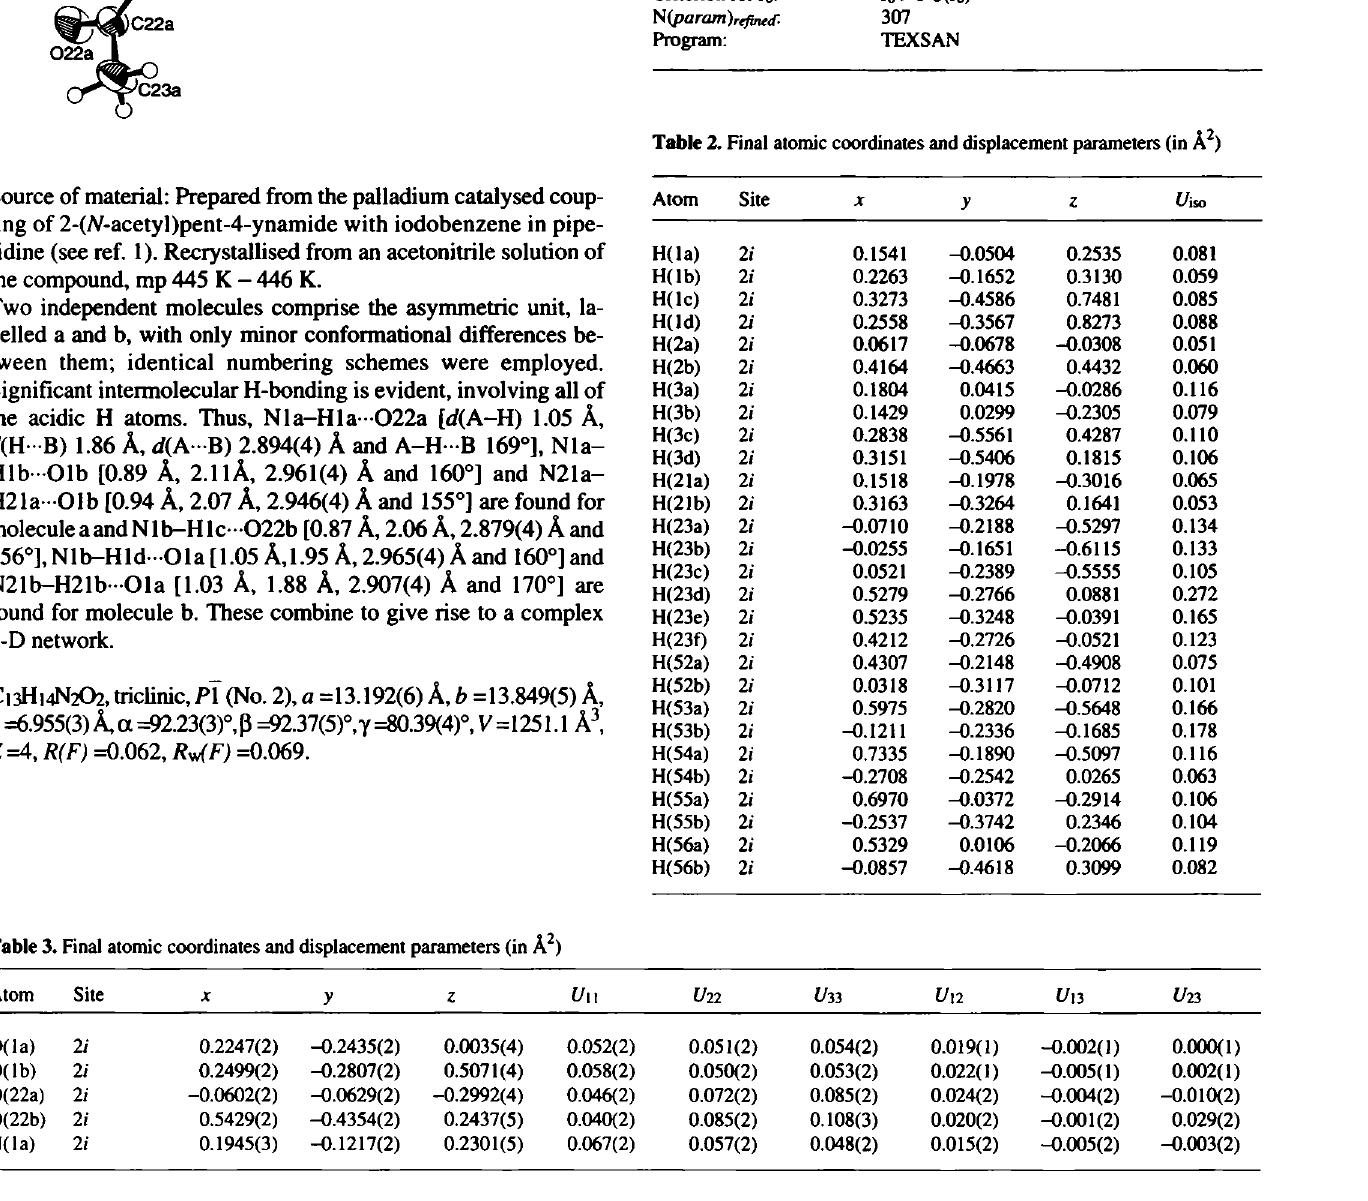
Table 1. Parameters used for the X-ray data collection